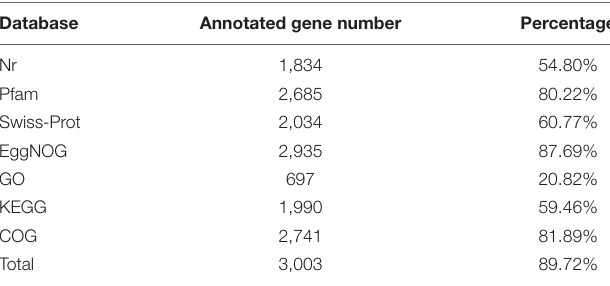
TABLE 3 | Gene functional annotation of strain